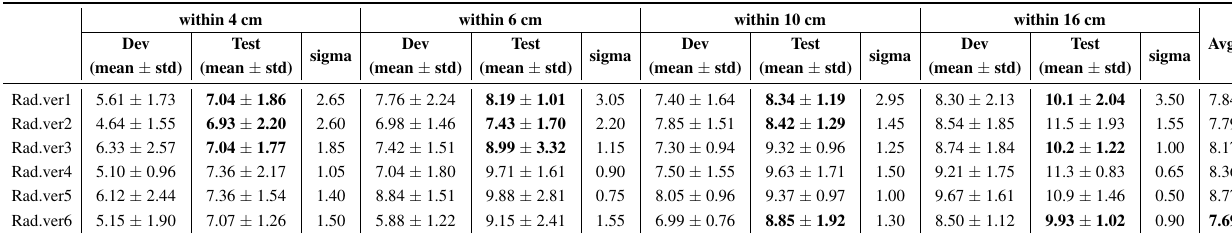
Table A4. HTERs (%) of the power histogram